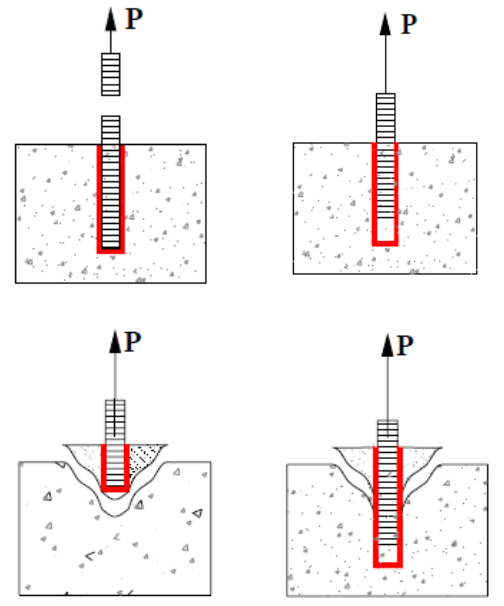
Figure 1. Mode of failures of Anchorages (ACI 355, 1991)